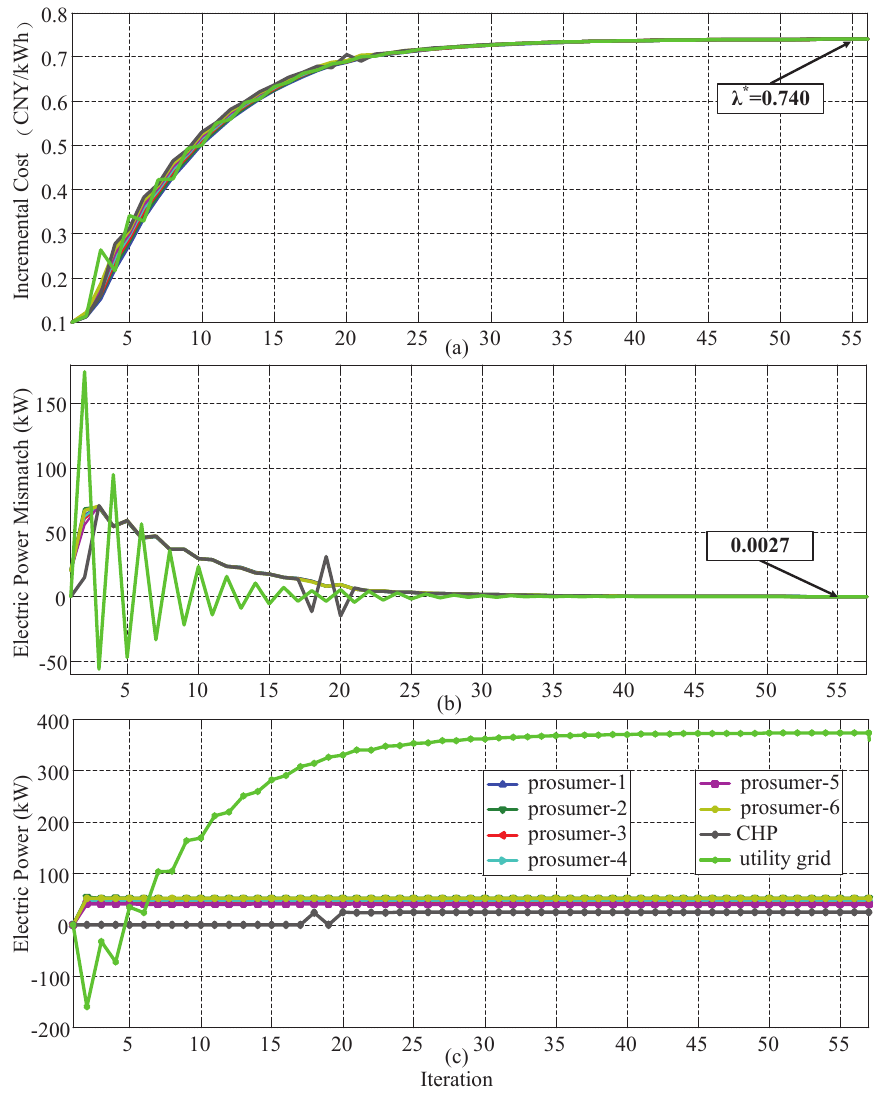
Figure 4. Convergence results of electric network: ( a ) incremental cost (utility); ( b ) local electric power mismatch; ( c ) local generated and consumed electric power.